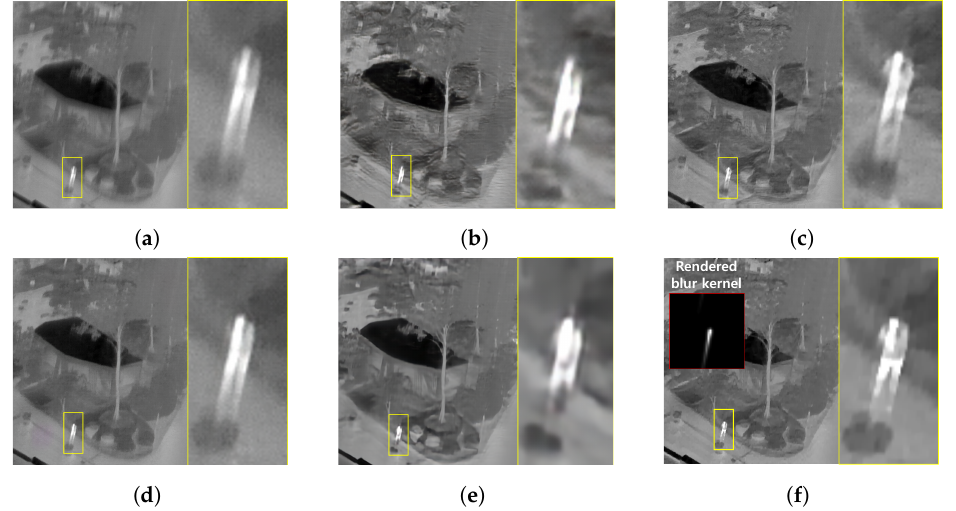
Figure 22. Qualitative comparison of motion deblurring results on the real blurry thermal image. ( a ) Real blurry thermal image acquired with a camera rotating at 40 ◦ / s , ( b ) SRN [33], ( c ) SIUN [36], ( d ) DeblurGAN.v2 [35], ( e ) CDVD [34], ( f )